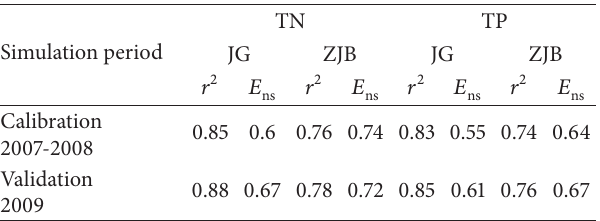
Table 5: Simulation results of TN and TP nonpoint pollution in the two